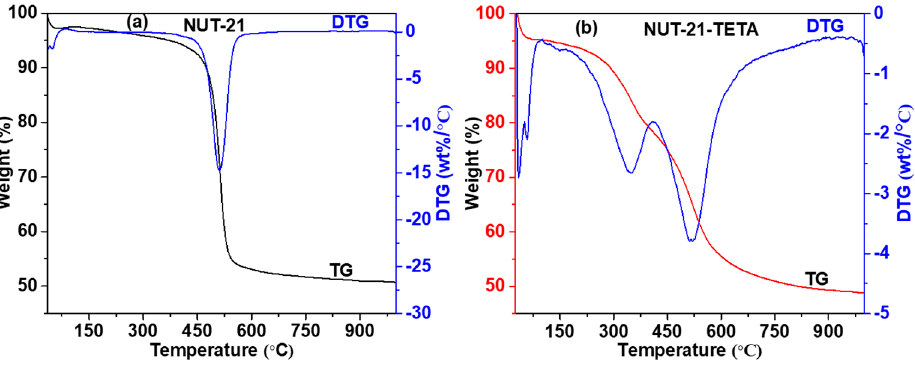
Figure 3. TG and DTG curves of ( a ) NUT-21, ( b ) NUT-21-TETA.